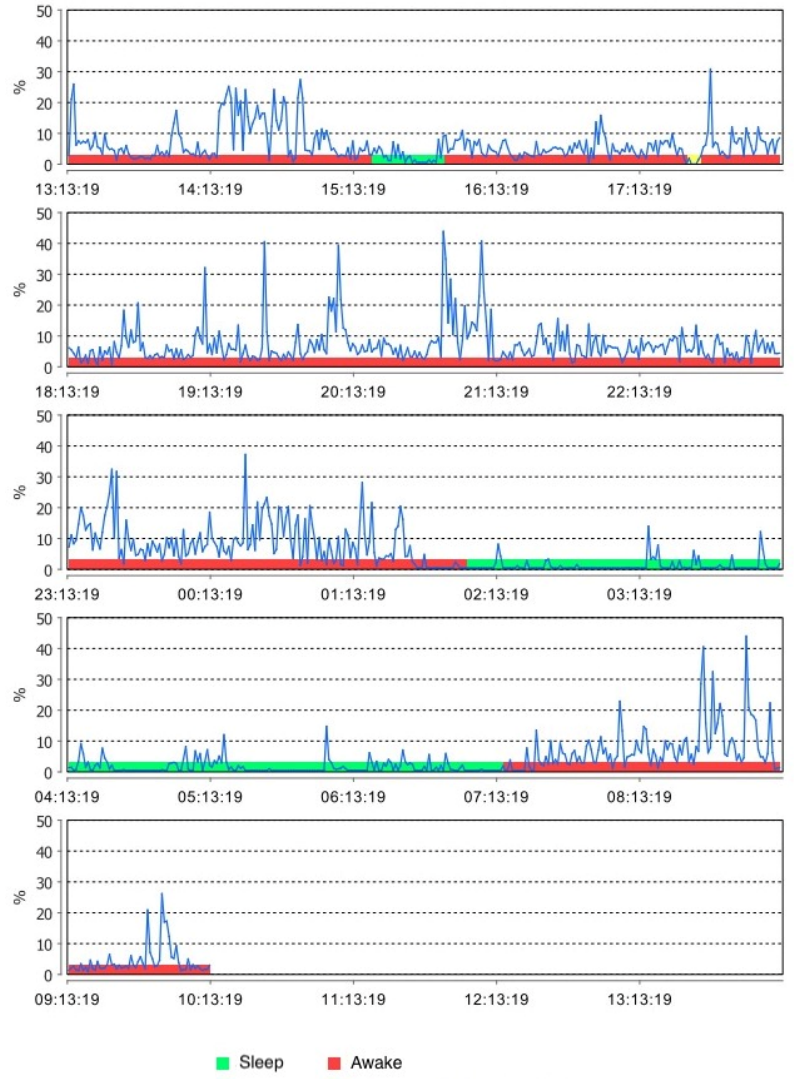
Figure 3. An example trace of electromyographic (EMG) recording of the masseter muscle by using a miniaturized device for in-home 24 h recordings.